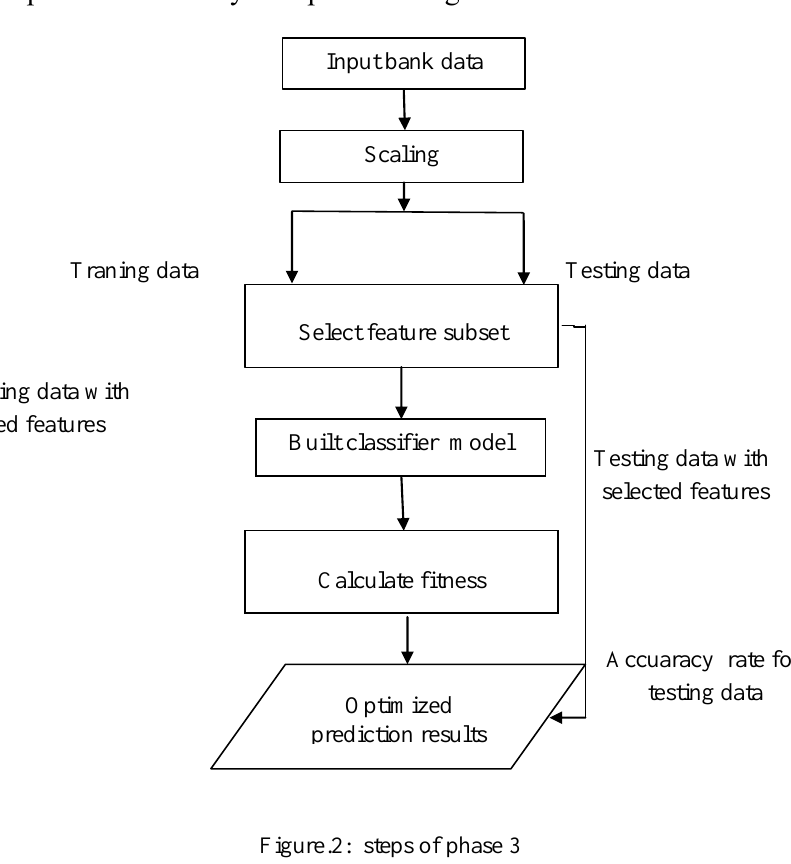
Figure.2: steps of phase